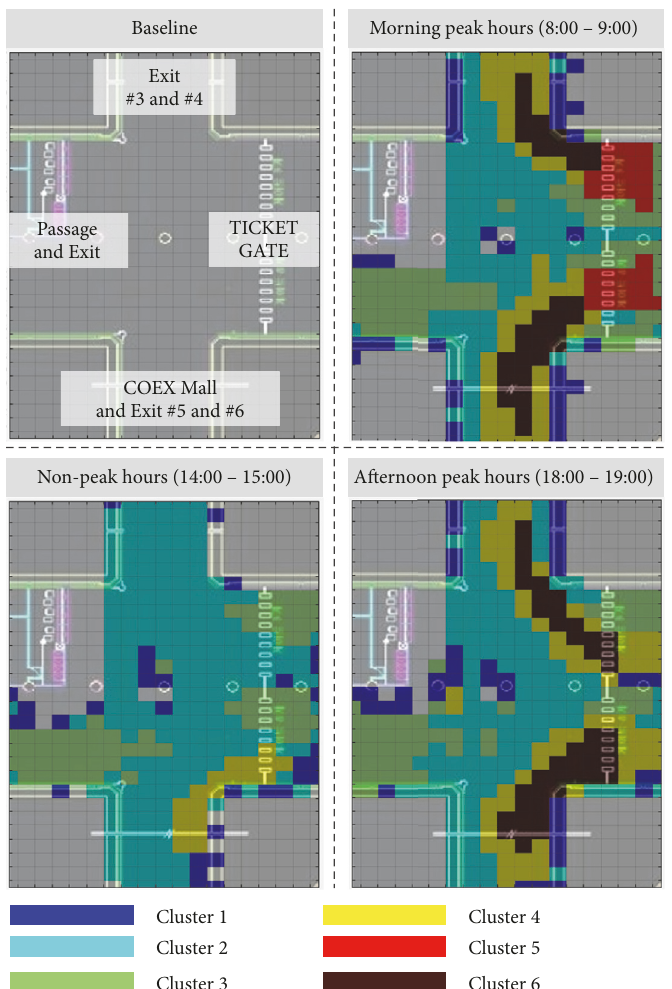
Figure 7: Spatial clustering results of Samseong station. The pedestrian volume was 6,965 in morning peak hours, 3,186 in nonpeak hours, and 8,343 in afternoon peak hours (unit: ped/h).